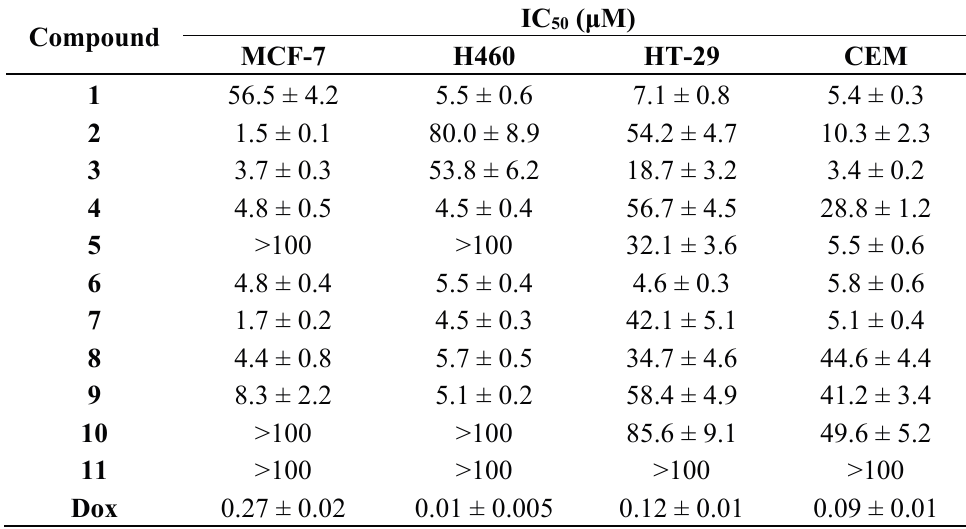
Table 2. Cytotoxicity of the isolated compounds from A . mellea against several cancer cell lines a .